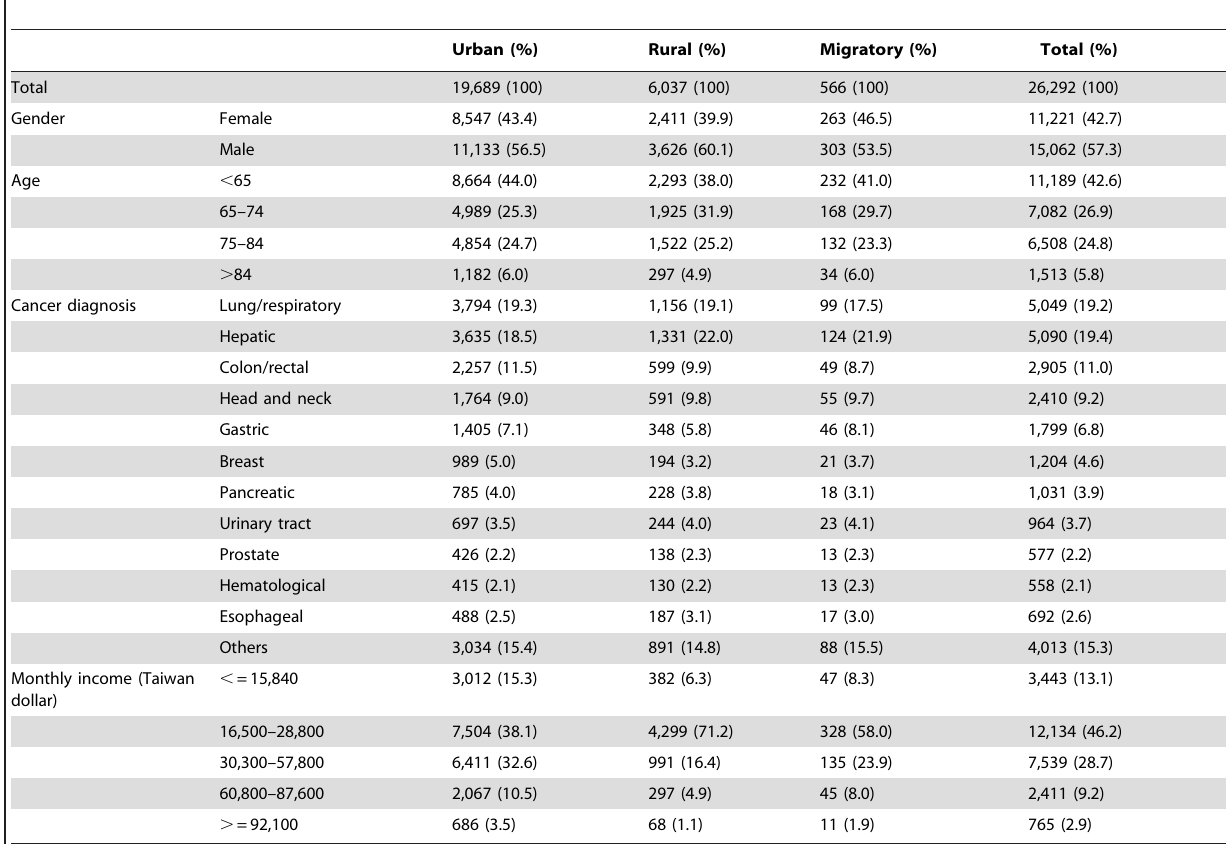
Table 1. Features of cancer patients with hospice care during 2000–2006, stratified by location of residence.